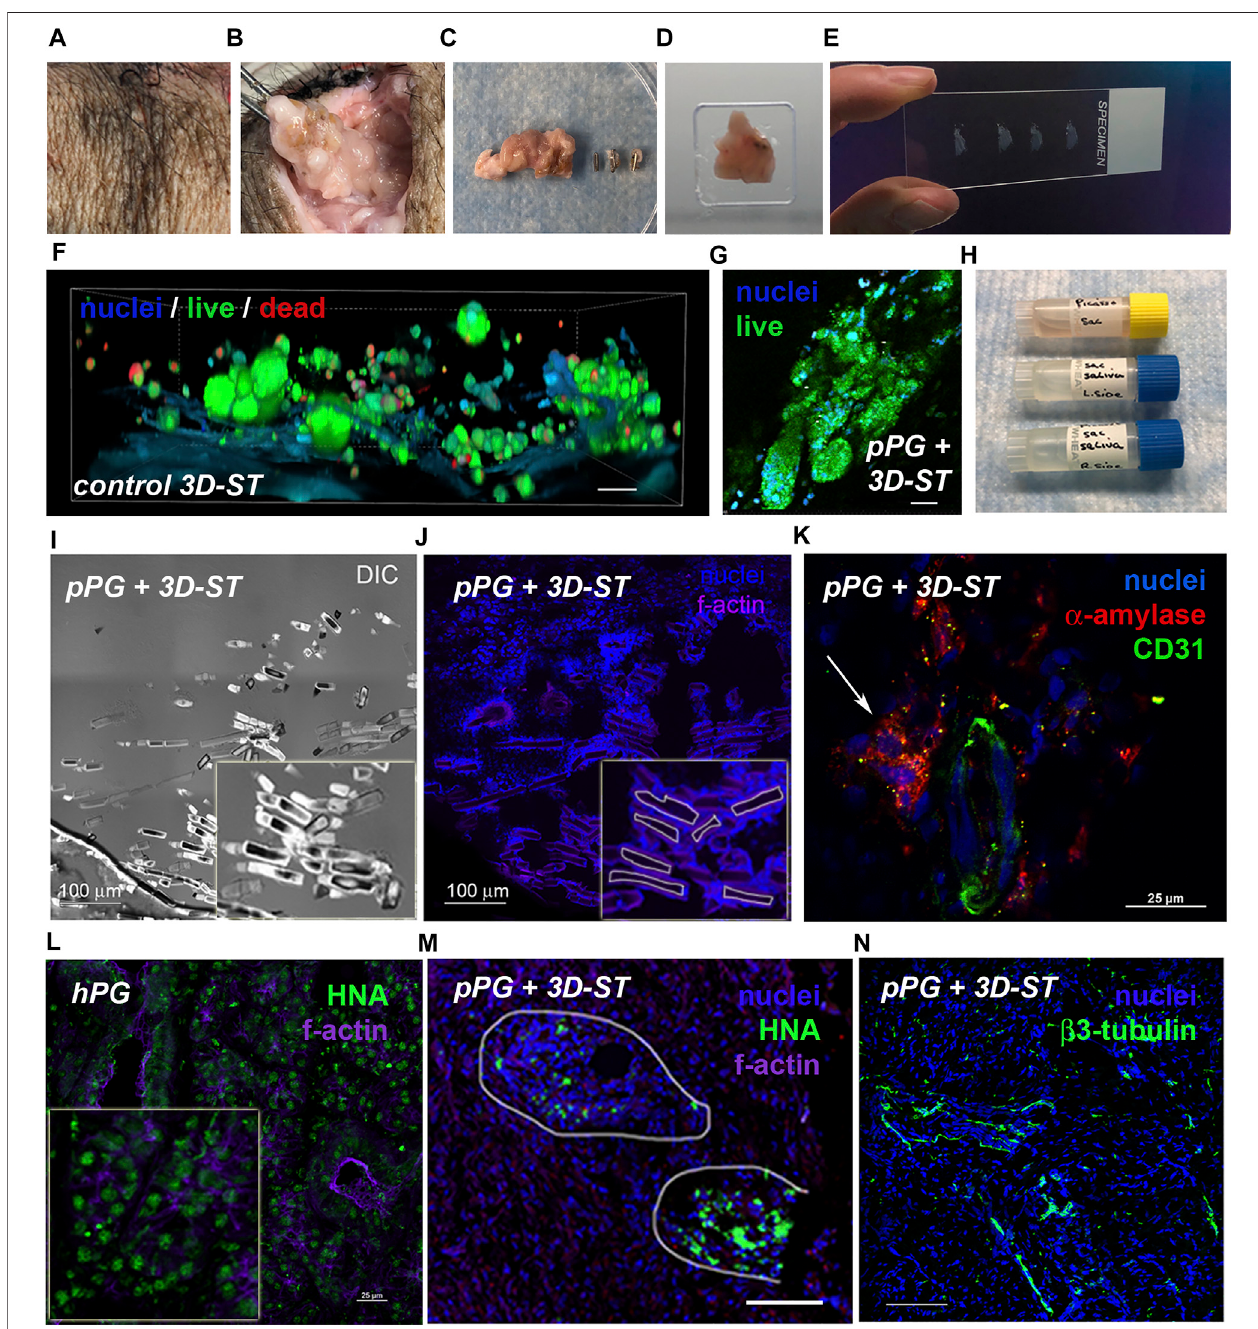
FIGURE6| Tissueprocessingtoassessviabilityandbiointegration. (A) Tissueispreparedfor3D-STresectionbeginningattheclosuresite; (B) 3D-STimplantation siteidenti fi edusingsurgicaldetailsdocumentedatthetimeofsurgery; (C) ligationsurgicalclipswereseparatedfromtheresectedtissue; (D) specimenswereembedded in OCT and (E) cyrosectioned for immunohistochemistry; (F) Live/Dead assays of time-matched in vitro controls; scale bar (cid:1) 25 μ m and (G) resected tissue 8 weeks post-surgery;scalebar (cid:1) 25 μ m. (H) Plasmaandsalivacollectionsareusedforhuman α -amylaseandGLucdetection; (I – J) visualizationofresectedtissuerevealed tissue response (blue nuclei) to surgical sutures; scale bar (cid:1) 100 μ m. (K) Vasculature (CD31, green) and human α -amylase (red, white arrow) adjacent to 3D-ST in serial cryosection of human nuclear antigen (HNA + ) structures ∼ 256 μ m away; scale bar (cid:1) 25 μ m. (L) Human nuclear antigen antibody (HNA, green; scale bar (cid:1) 25 μ m) validated using human parotid tissue was (M) present in structures in resected implant tissue after 4 weeks; scale bar (cid:1) 100 μ m. (N) Nerve fi bers in tissue adjacent to implant, ∼ 448 μ m away from HNA + structures, was shown by the presence of beta-III tubulin (green) staining traversing the tissue; scale bar (cid:1) 100 μ m.